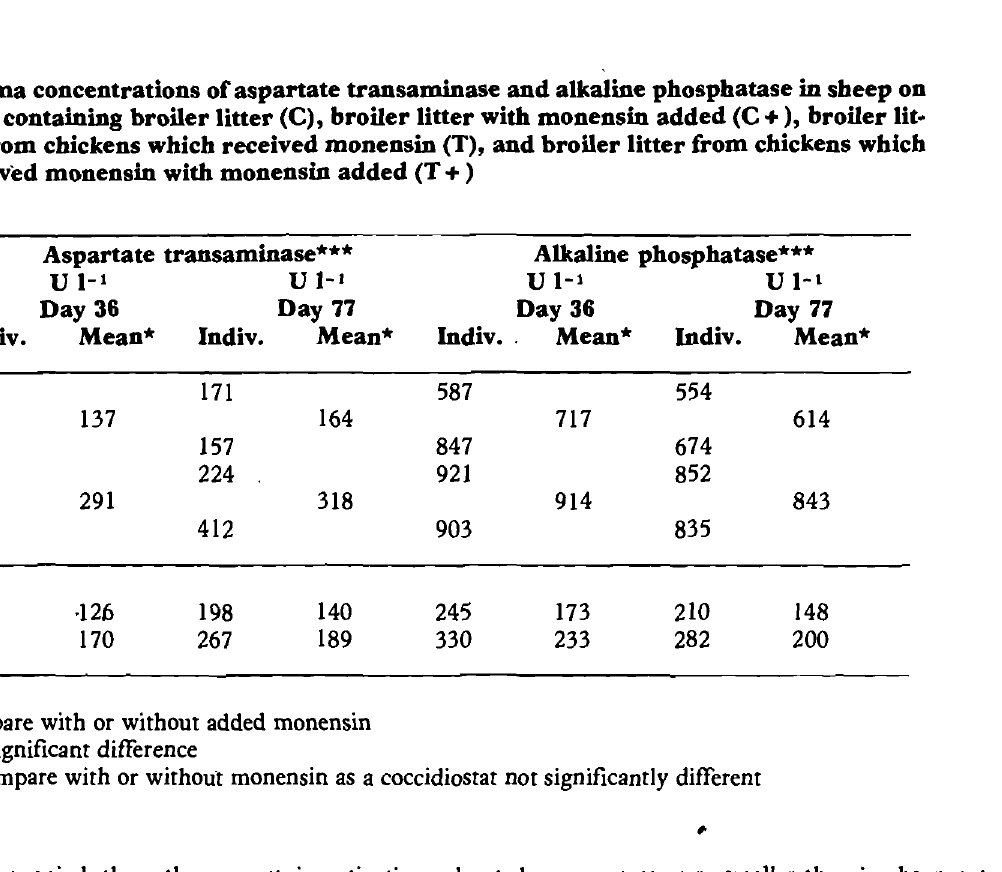
Table 5: Plasma concentrations of aspartate transaminase and alkaline phosphatase in sheep on diets containing broiler litter (C), broiler litter with monensin added (C +), broiler lit- ter from chickens which received monensin (T), and broiler litter from chickens which